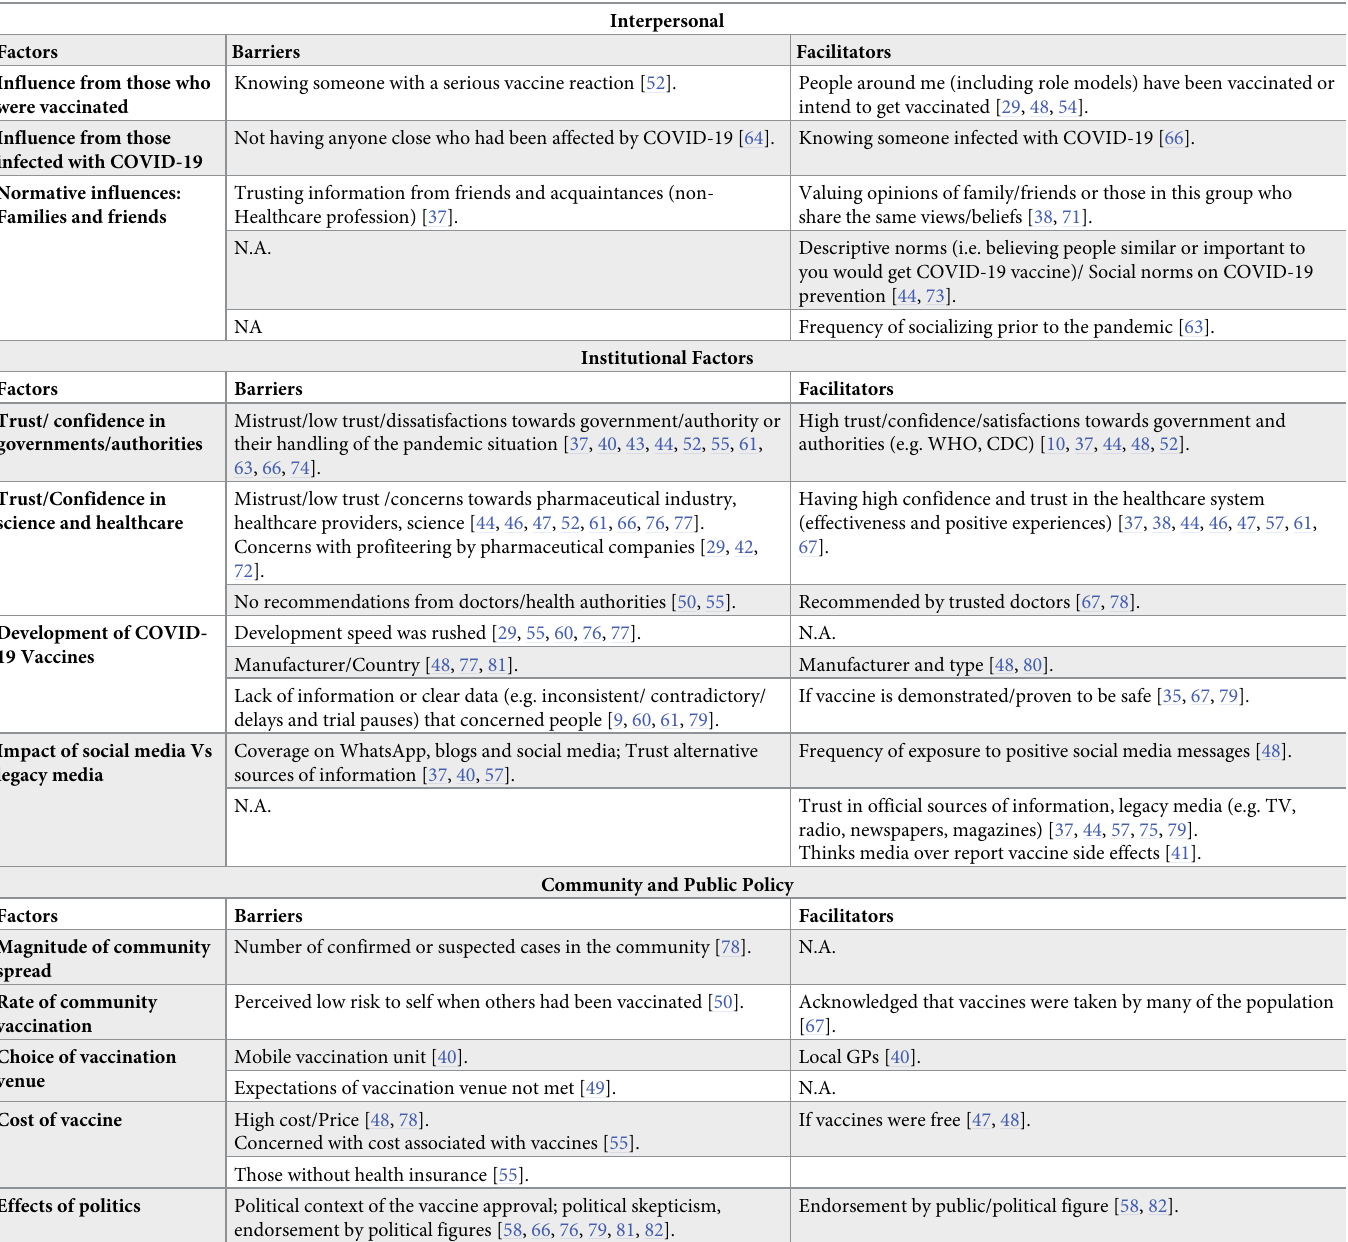
Table 6. Other factors (interpersonal, institutional, community, public policy).